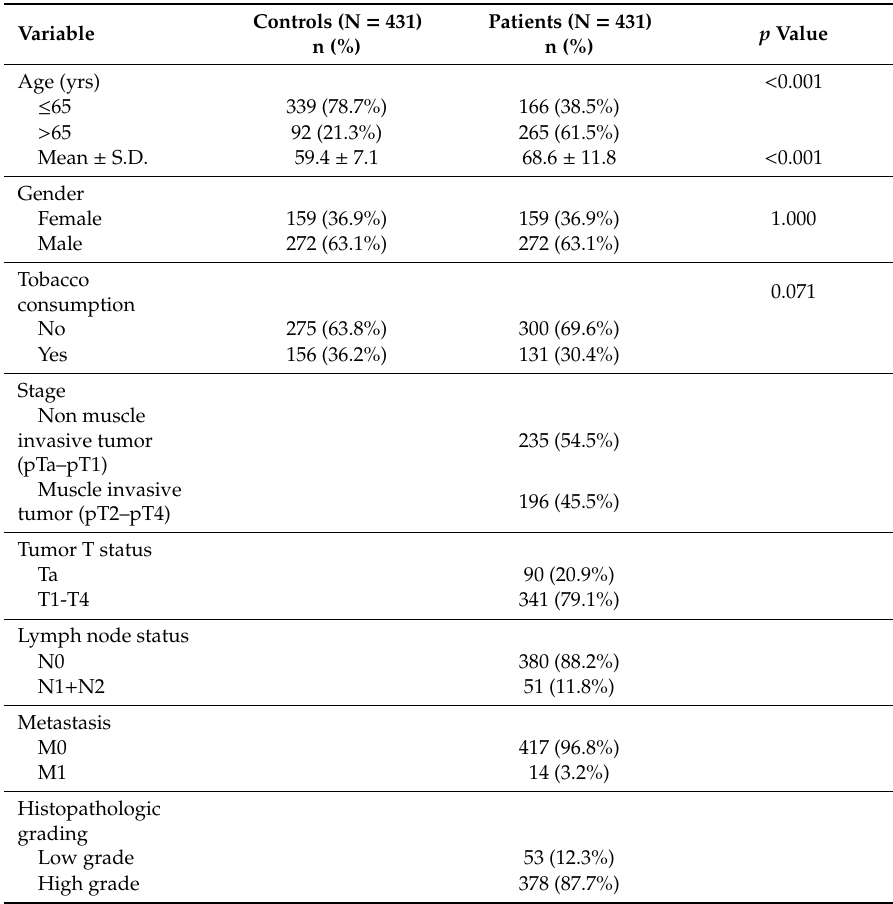
Table 1. The distributions of demographical characteristics in 431 controls and 431 patients with urothelial cell carcinoma